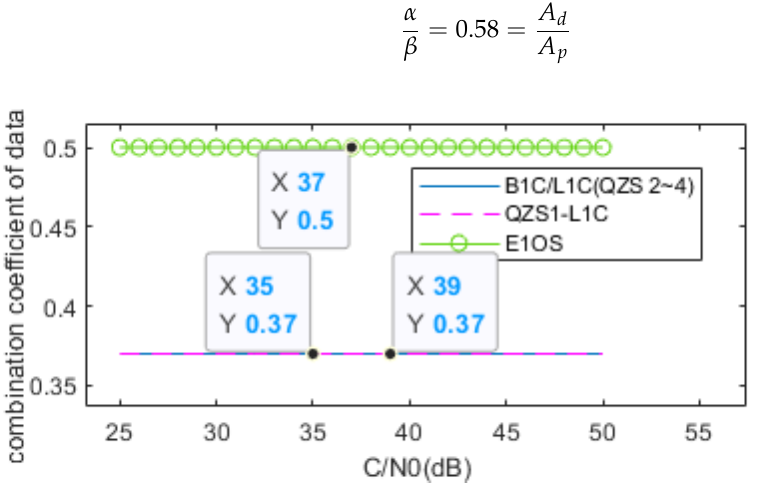
Figure 5. The combination coefficients of data component.